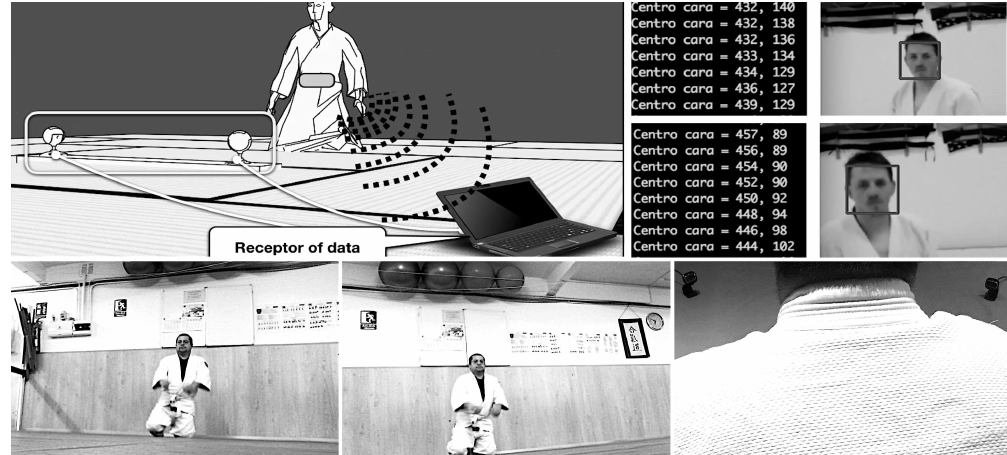
Figure 9. Top-left: Setup of the dual camera system and face detection for stereoscopic reconstruction (designed for the MyShikko prototype [13]). A smartphone is schematically represented (attached to the practitioner’s hara and wirelessly transmitting inertial data to a host), but it is not necessary for the stereo 3D reconstruction. Top-right: The face recognition algorithm is being applied on the captured video from an aikido practitioner while walking on knees. The numerical output in the consoles represents (in time) the 2D coordinates of the center of the face being detected. Epipolar geometry later allows the derivation of 3D spots (tackled in Sections 4.3 and 6.4). Bottom: Registered cameras (shown at the right image) in a stereoscopic configuration. Photos taken at Judelda dojo (Elda,